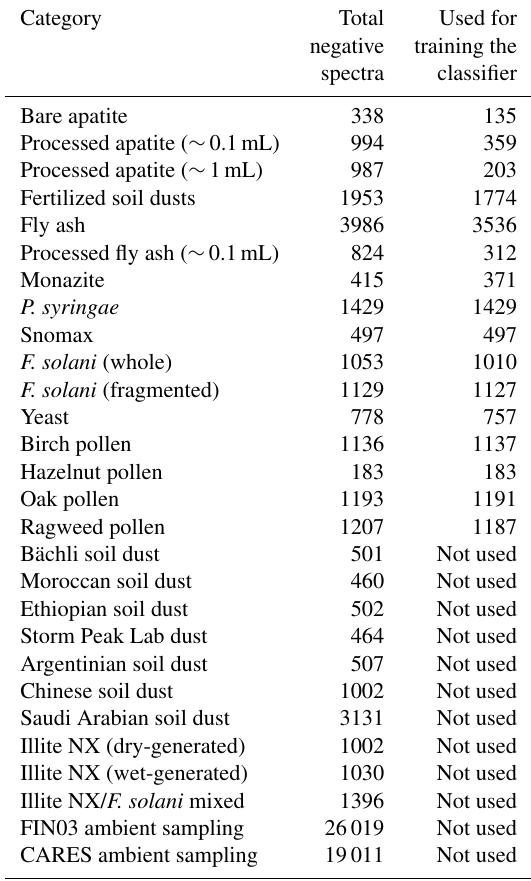
Table 2. Summary of particle statistics for samples used to both train and test the